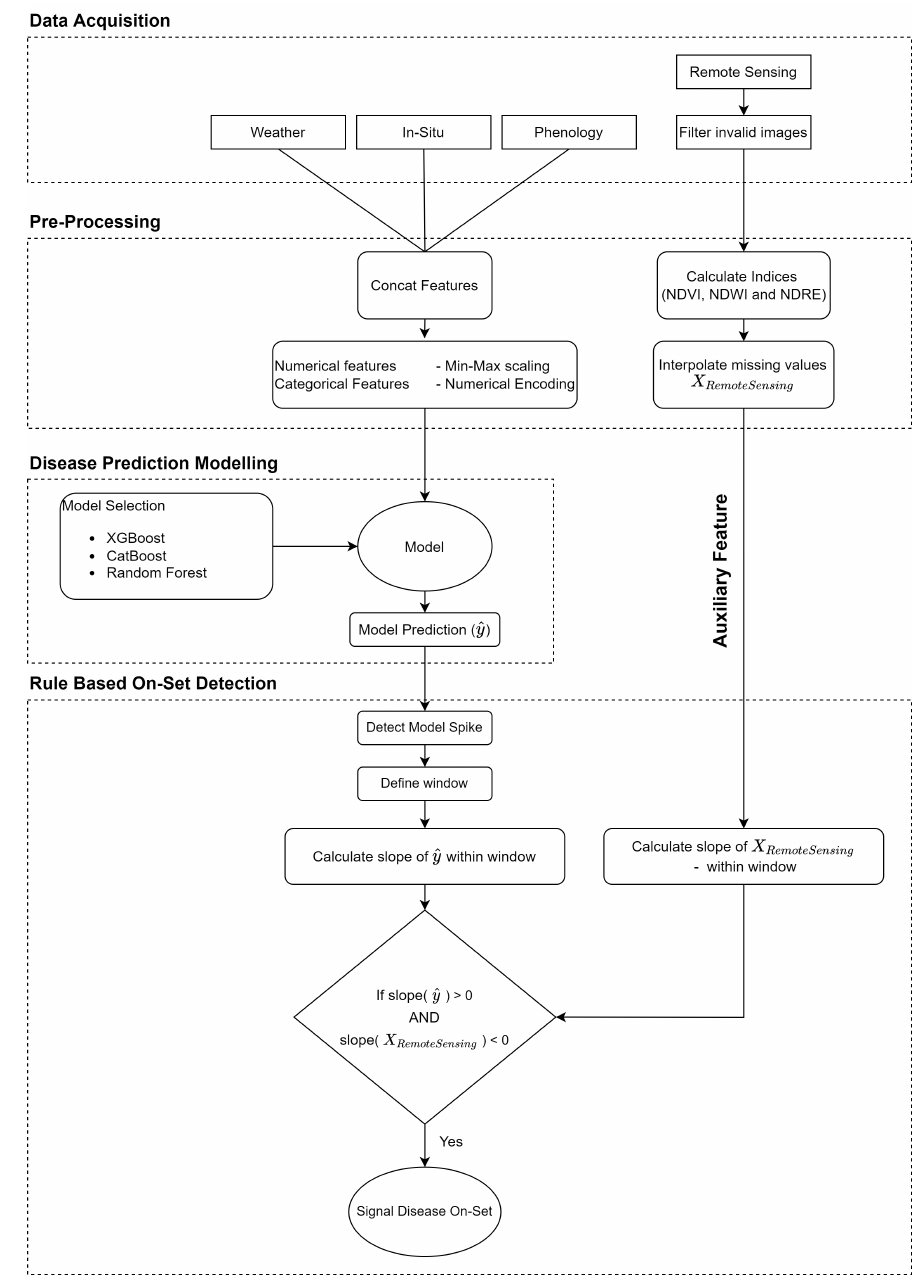
Figure 6. Flowchart describing the Rule-Based Onset-Detection